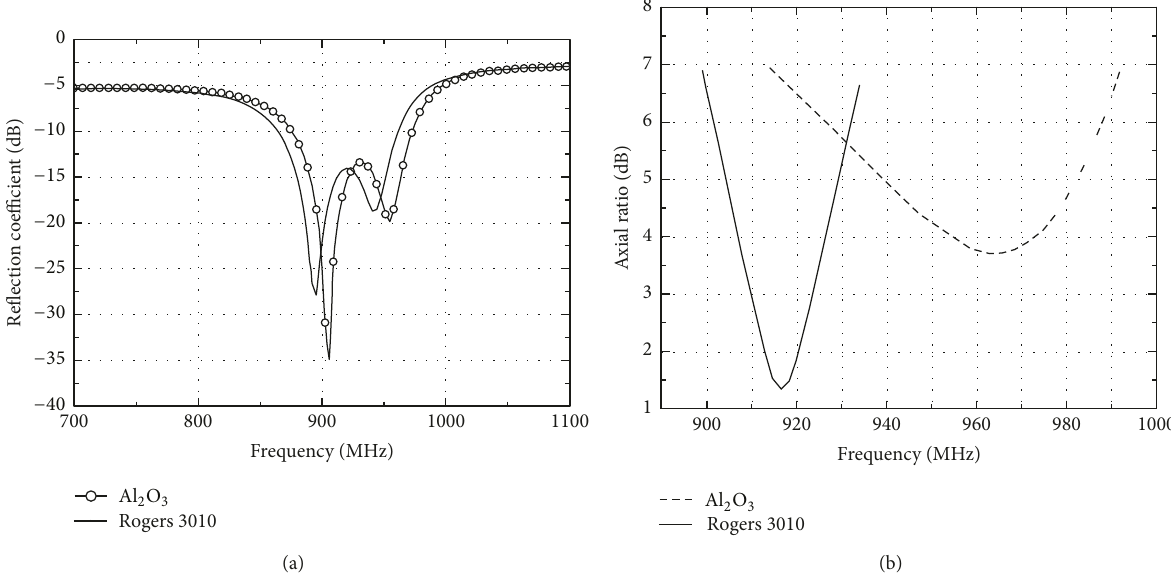
Figure 6: The comparison of the proposed antenna with different materials: (a) reflection coefficients; (b) axial